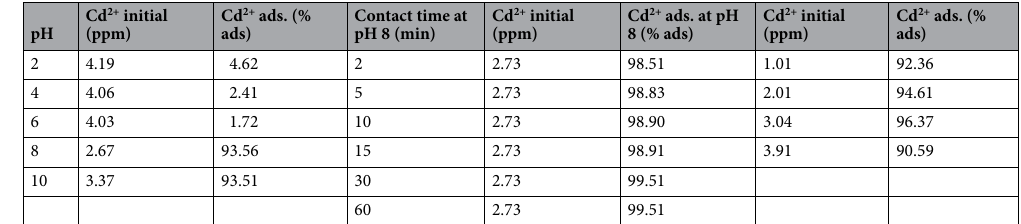
Table 2. Percentage Cd 2+ adsorption by magnetite at different pH values over 60 min of contact time.